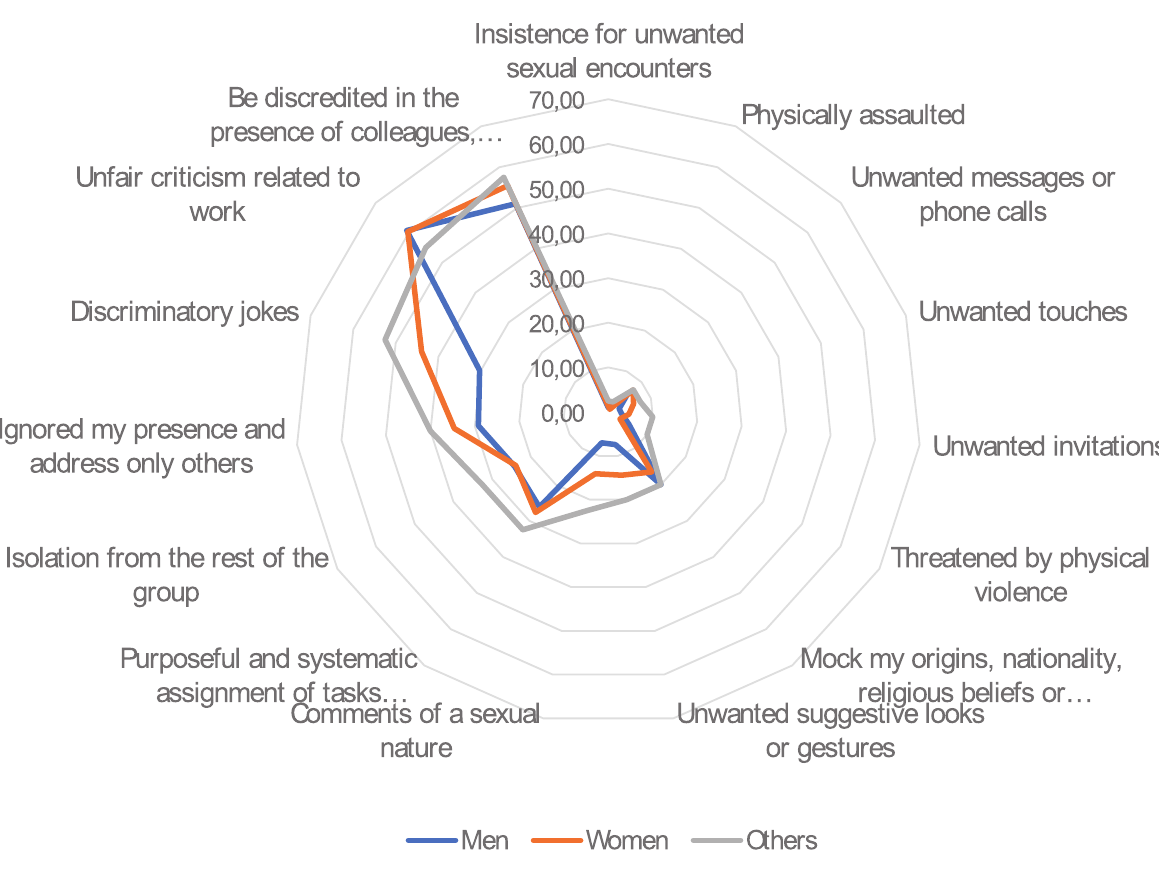
Figure 6. Percentage of forms of moral harassment that students, professors, and staff claim to have suffered separated by gender. Full text of the summarized items: ”Purposeful and systematic assignment of tasks inferior or superior to your competences”, ”Mock my origins, nationality, religious beliefs, or political beliefs”, and ”Be discredited in the presence of colleagues, superiors, or